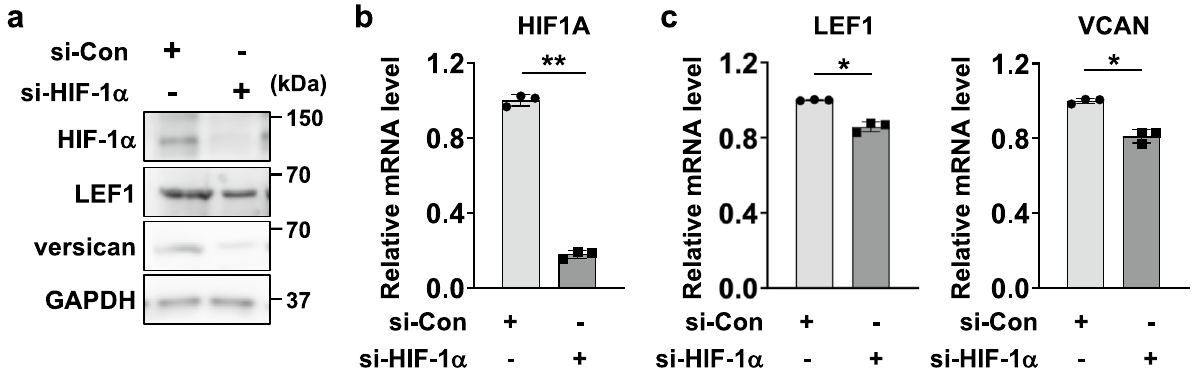
Figure 2. HIF-1α knockdown suppresses mRNA levels of trichogenic genes in dermal papilla cells (DPCs). (a,b) DPCs were treated with control siRNA (si-Con) or HIF-1α (si-HIF-1α) for 48 h. Cells were subjected to western blotting ( a ) with HIF-1α and GAPDH antibodies or real-time quantitative PCR (RT ‒ qPCR, b ). (c) si-Con- or si-HIF-1α-transfected DPCs were used to perform RT–qPCR to determine the mRNA levels of genes involved in trichogenesis (LEF1 and VCAN). Relative mRNA levels are presented as the means and standard deviation (SD) calculated with data from 3 independent